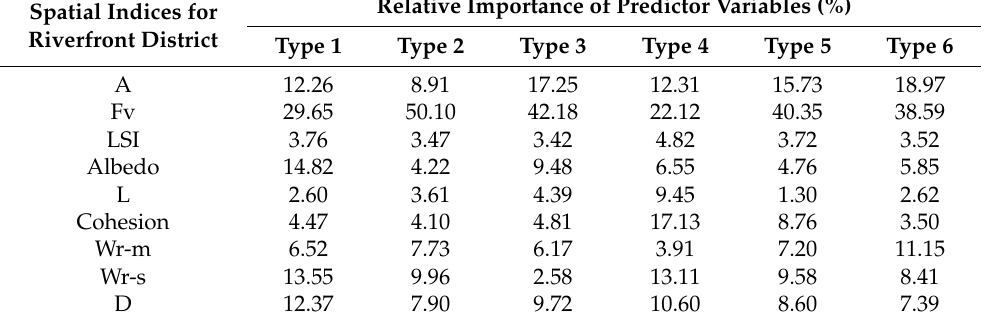
Table 9. Relative importance of the spatial quantified factors to LST of riverfront greenspace in six river-type zonings. Relative Importance of Predictor Variables (%) Spatial Indices for Riverfront District Type 1 Type 2 Type